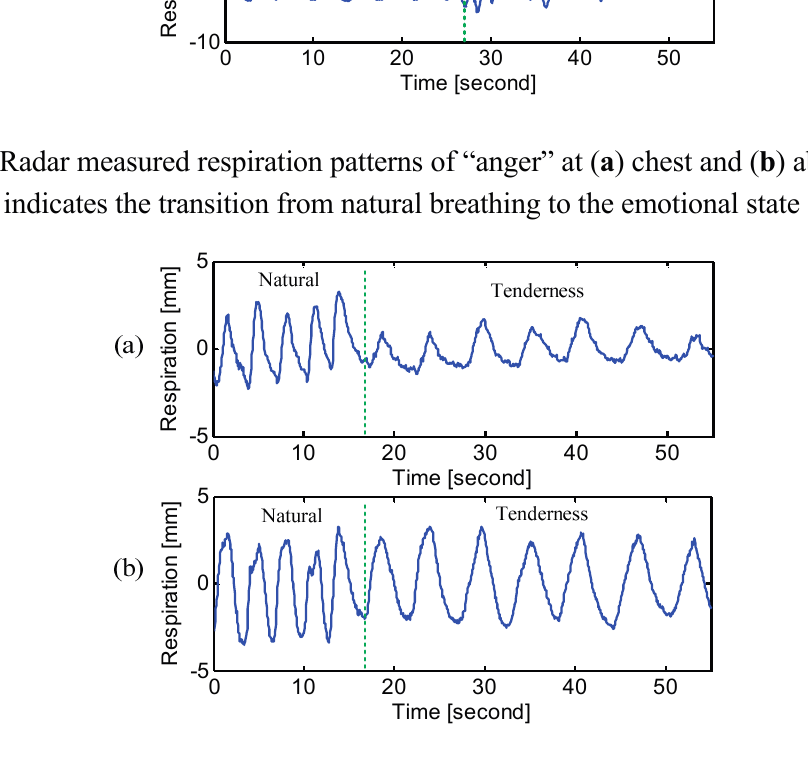
Figure 12. Radar measured respiration patterns of “tenderness” at ( a ) chest and ( b ) abdomen. The dashed line indicates the transition from natural breathing to the emotional state of